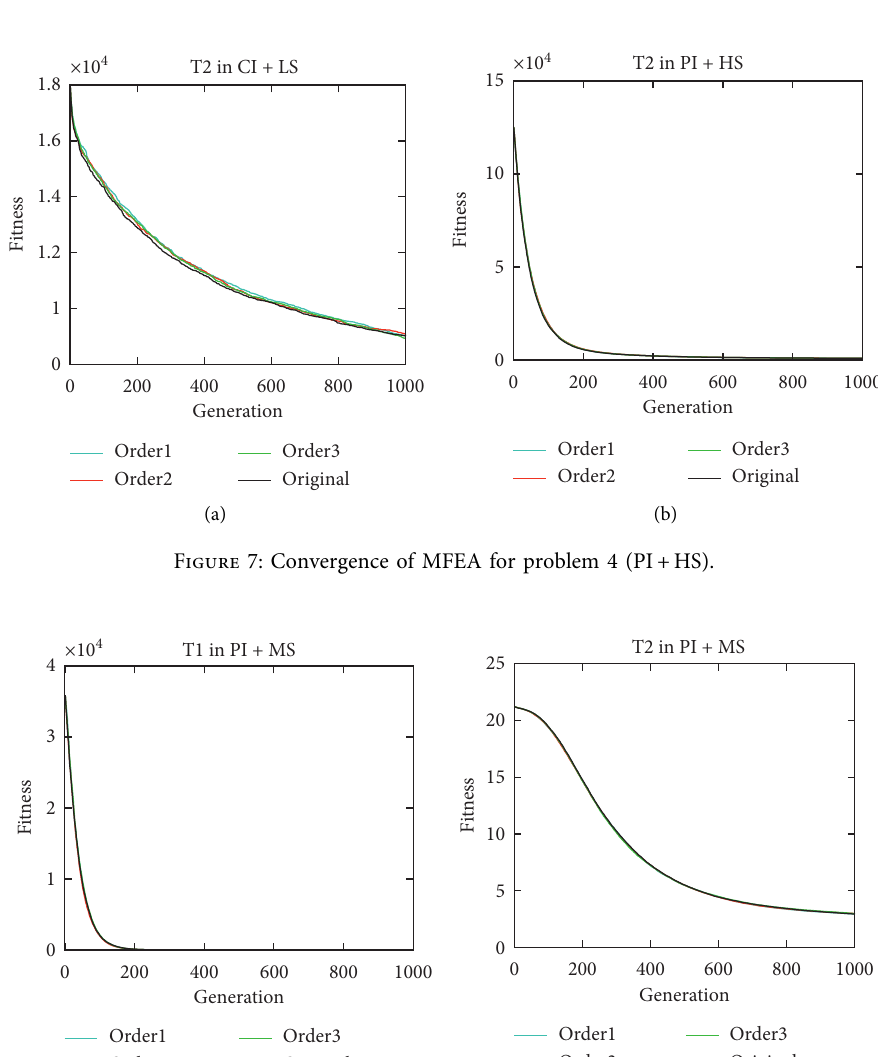
Figure 6: Convergence of MFEA for problem 3 (CI+LS).